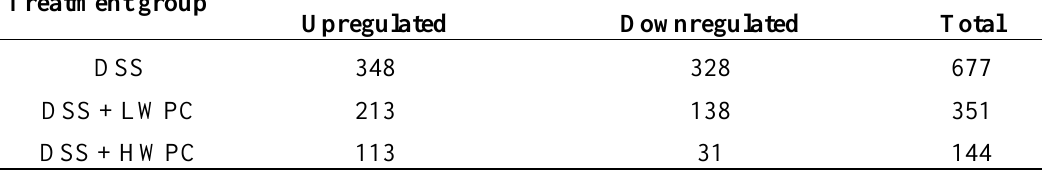
Table 3. The number of genes differentially regulated by DSS and whey protein concentrates.